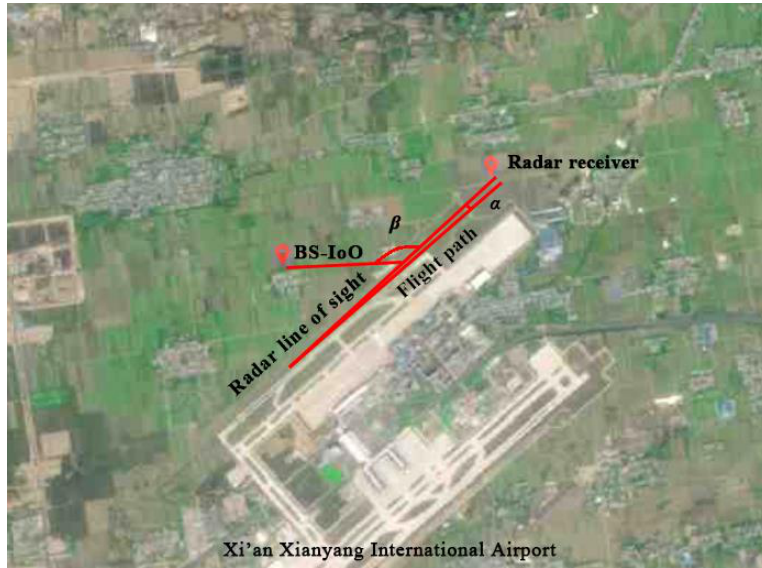
Figure 13. Sketch of radar setup.